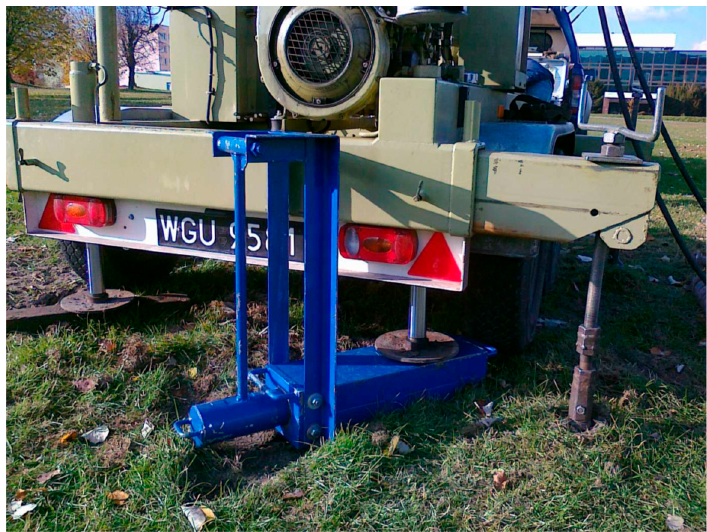
Figure 4. Steel beam with a hammer used to generate shear waves in SDMT.